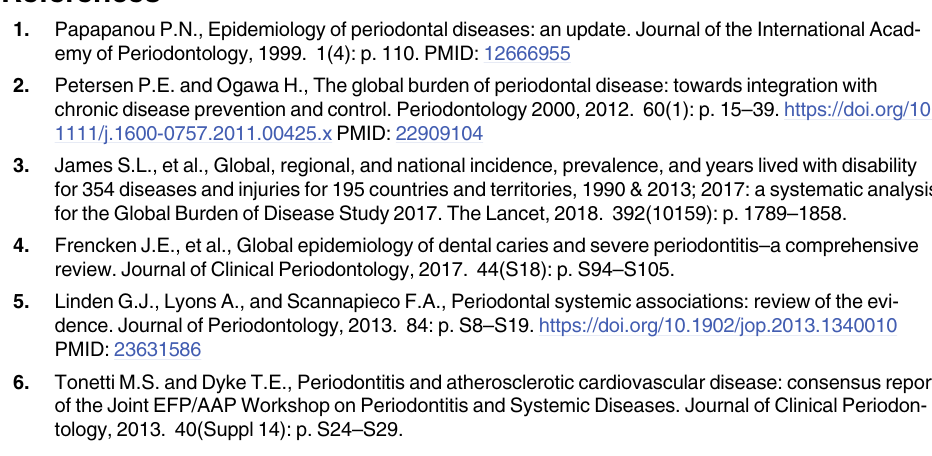
S7 Table. Stability of opinion scores between e-Delphi round 1 and 2 for each patient par- ticipant. A measure of the change in an individual’s scoring between each round of the e-Del- phi. S8 Table. Face to face consensus voting breakdown. Voting scores for ‘top 10’ outcomes with number and percentage of stakeholder groups scores presented. Consensus for inclusion was pre-determined as 70% of